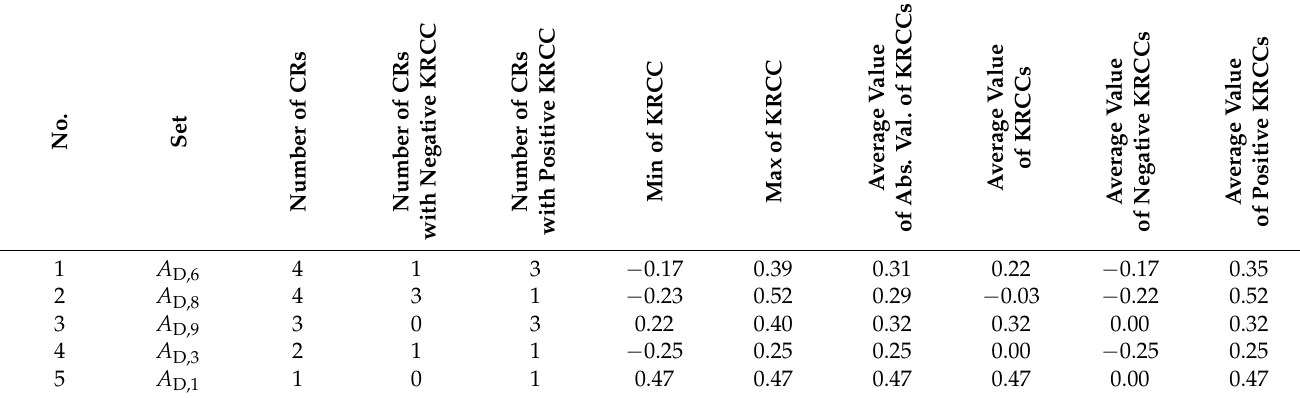
Table 9. Characteristics of SSCRs Related to Particular Sets A D, j j = 1, 3, 6, 8, 9.